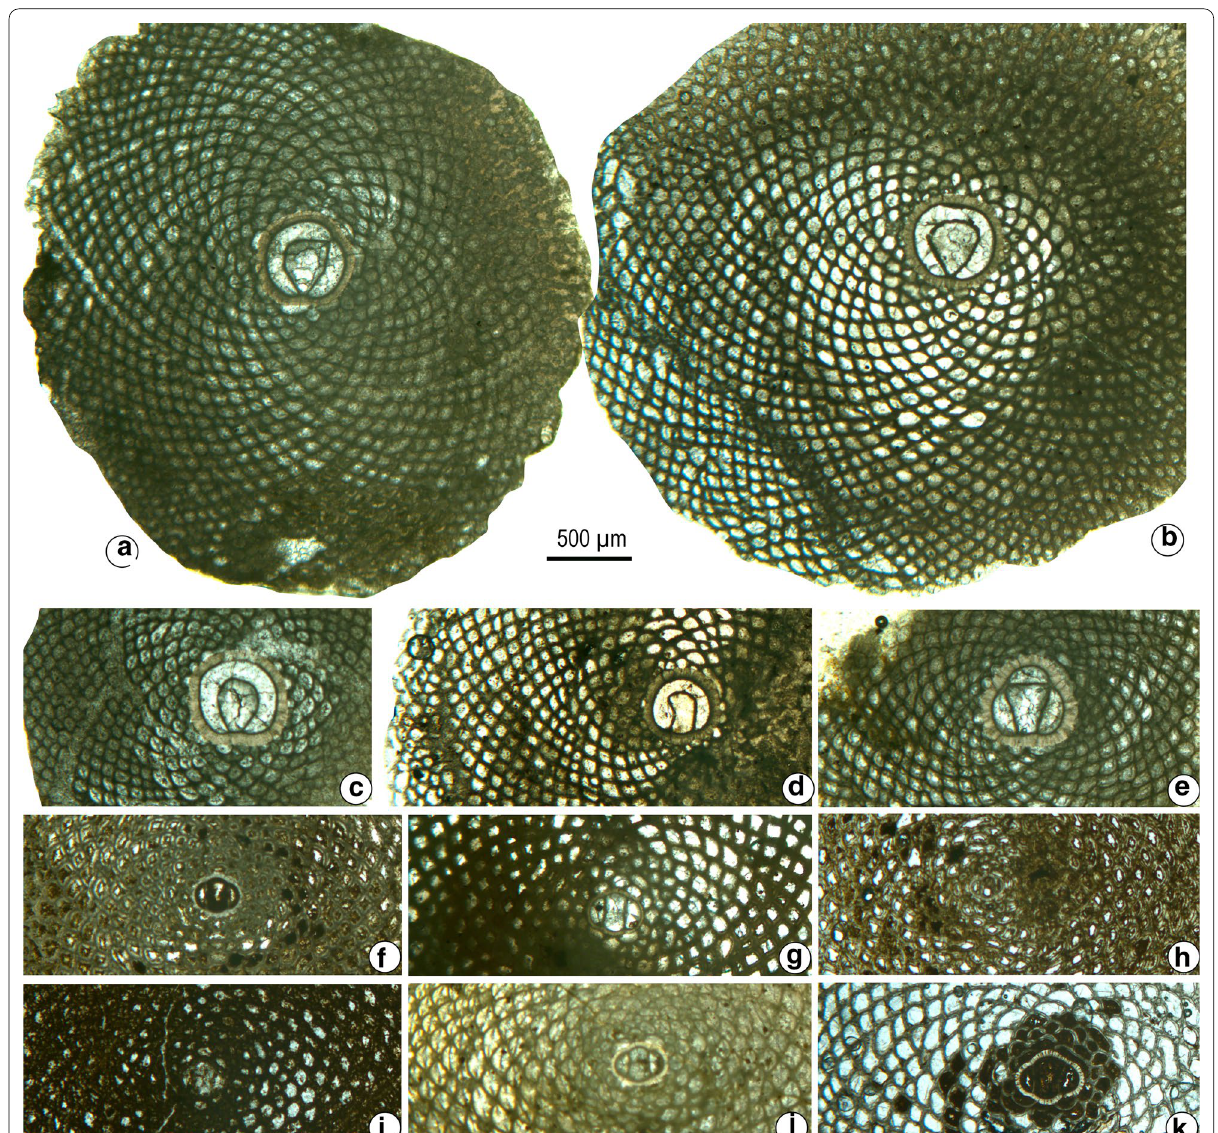
Fig. 14 Equatorial sections of O. ex. interc. gruenbachensis–apiculatus ( a – e ) and O. pamiri ( f – k ) from the Taraklı Formation in Epçeler A and Dereköy sections. a EPA18-4. b DE7-17. c EPA18-5. d DE7-4, e EPA19-2. f DE7-21. g EPA19-1. h EPA18-1. i EPA18-2. j EPA18-3. k